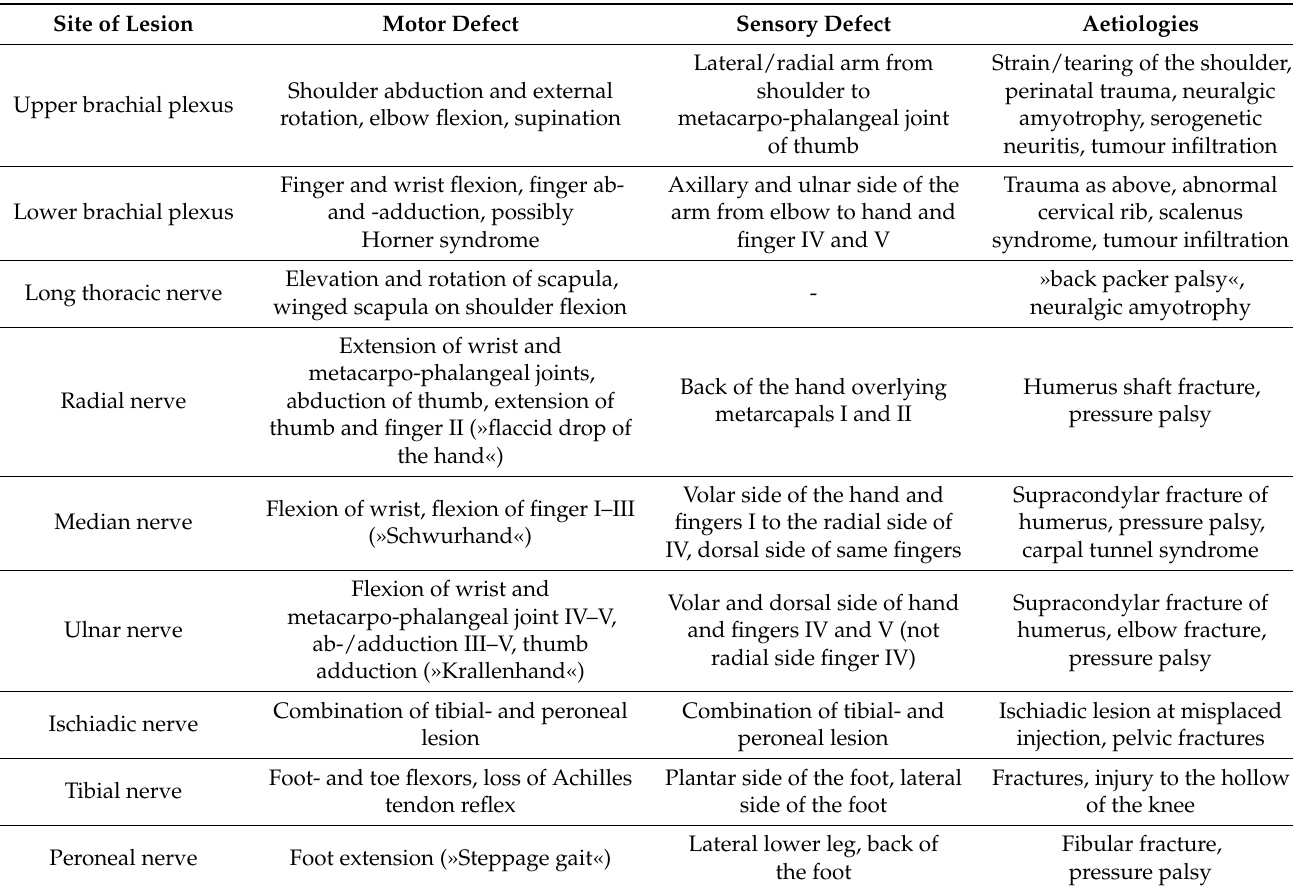
Table 4. Clinical appearance and aetiology of peripheral nerve